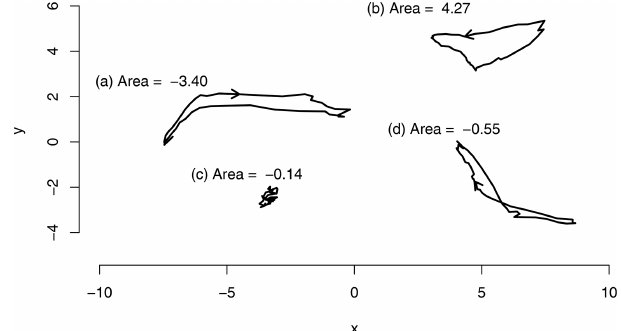
Figure 1. Example polygons and their areas, Eq. (10); the arrows indicate the directionality. (a) Clockwise polygon with a negative area. (b) Counterclockwise polygon with a positive area. (c) Chaotic polygon with a very low area. (d) Polygon with a single intersection and both a clockwise and counterclockwise portion. The clockwise portion is slightly larger than the counterclockwise portion; there- fore the area is slightly